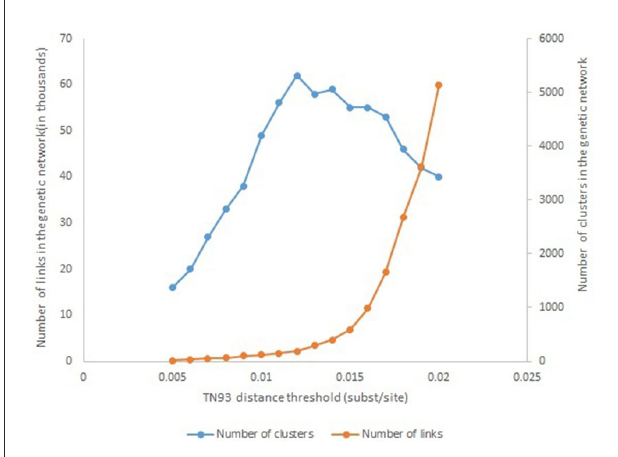
FIGURE1 Number of genetic links and transmission clusters, as a function of the TN93 distance threshold.